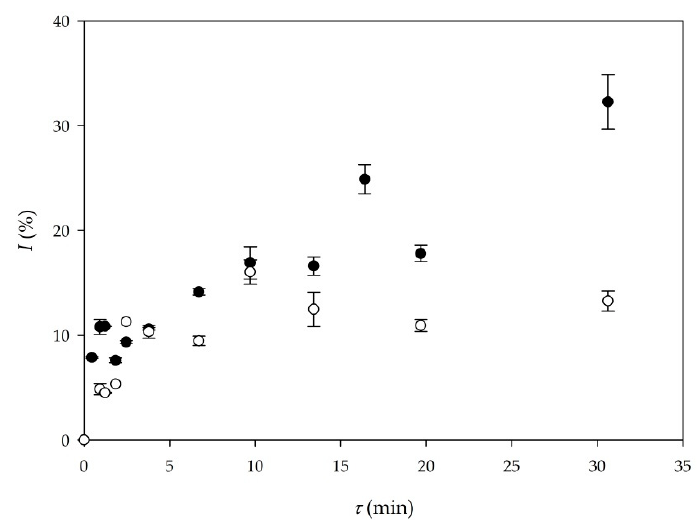
Figure 2. Comparison of biodiesel yield depending on oil origin ( ○ —edible oil (Experiment 5), ● — waste cooking oil (WCO) (Experiment 6)).